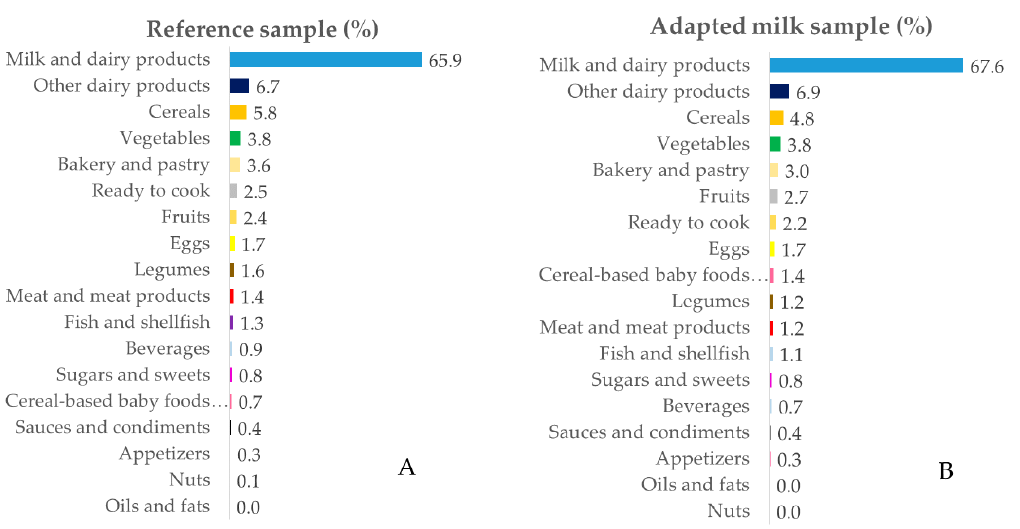
Figure 1. Percentage of the 18 food groups sources, in terms of the total calcium intake (%), among the reference sample ( A ) and the adapted milk consumer sample ( B ) of the Spanish Pediatric Population (EsNuPI) study.